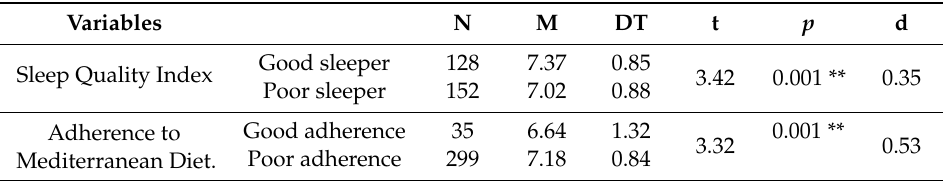
Table 2. Descriptive average academic grade, according to sleep quality and adherence to the Mediterranean